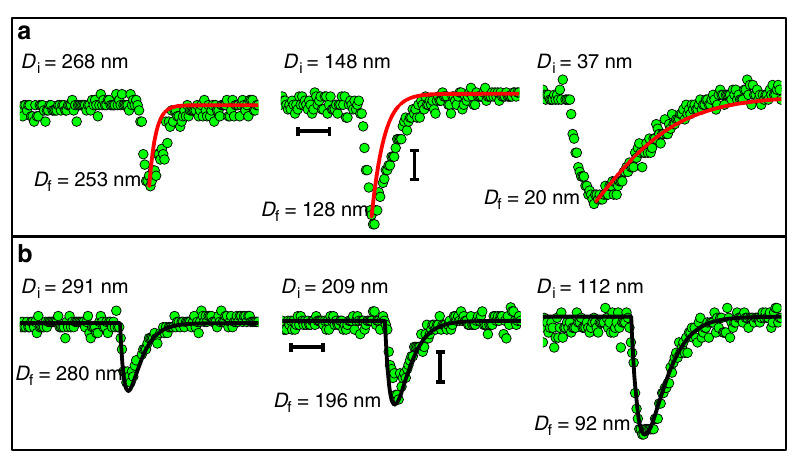
Fig. 3 A magni fi ed view of peaks measured at different surface separations ( D i ) in 2mM NaNO 3 . a The red solid lines describe the motion of the lower surface from D i to D f in the presence of hydrodynamic damping alone as obtained by the analytical solution D t ð Þ ¼ D Fig. 4a) the relaxation of the surfaces from D f back to D i is signi fi cantly slower than can be accounted for by hydrodynamic damping. Scale bars: horizontal – 0.4sec; vertical – 5nm. b The black solid lines are the solution to equation (3) which describes the transient motion in surface separation D ( t ) in response to a positive step potential ( ‒ 0.2V → + 0.2V), where for all traces the parameters are fully determined (no adjustable parameters) (Supplementary note 6). Scale bars: horizontal – 0.4sec; vertical –